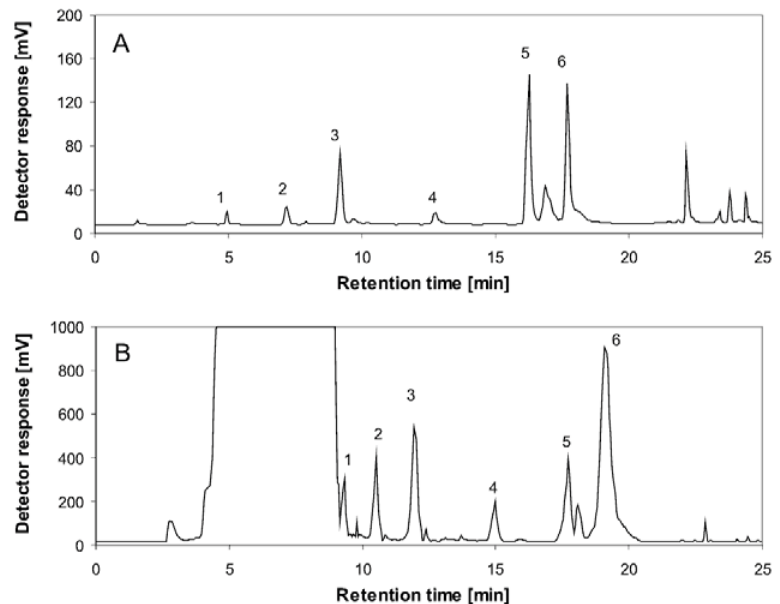
Figure 4. GC-FID chromatograms of Mentha piperita L. real extract gained by SPME (A) and SDME (B) method 1 – α -pinene, 2 – myrcene, 3 – limonene, 4 – α -thujone, 5 – menthone, 6 –